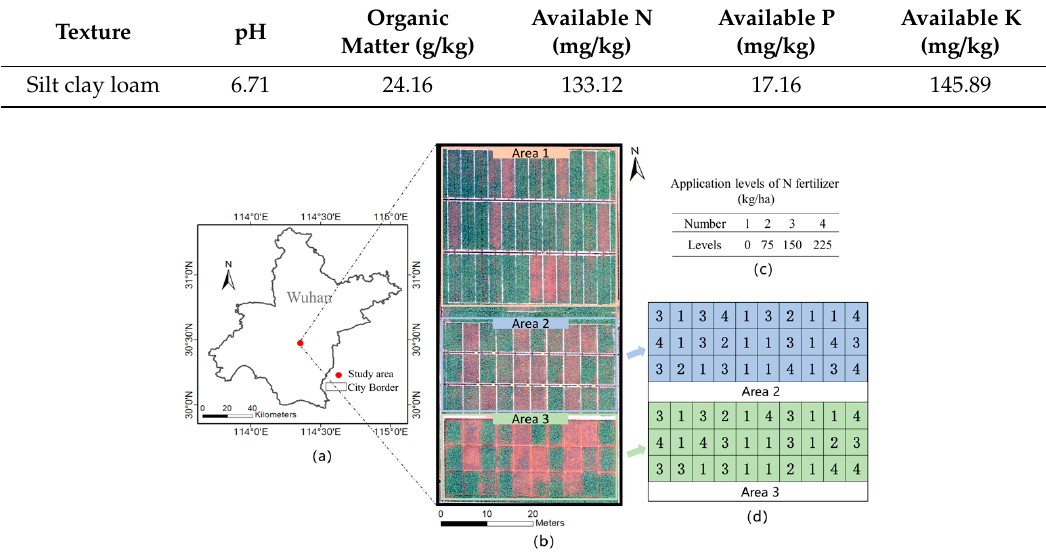
Figure 1. Study area and arrangement of the experimental sites: ( a ) geographic map showing the study area, ( b ) test fields for rapeseed, ( c ) nitrogen fertilizer application levels, and ( d ) application levels of nitrogen fertilizer in each plot in Area 2 and Area 3 according to the table.